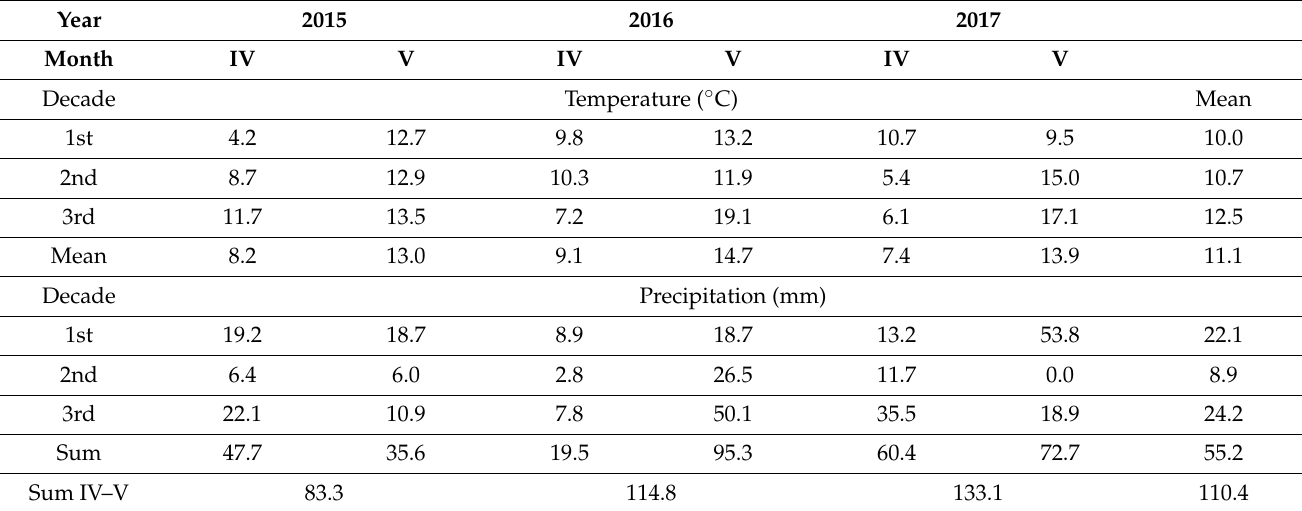
Table 1. Temperature ( ◦ C) and precipitation (mm) in the experiment site during the growing